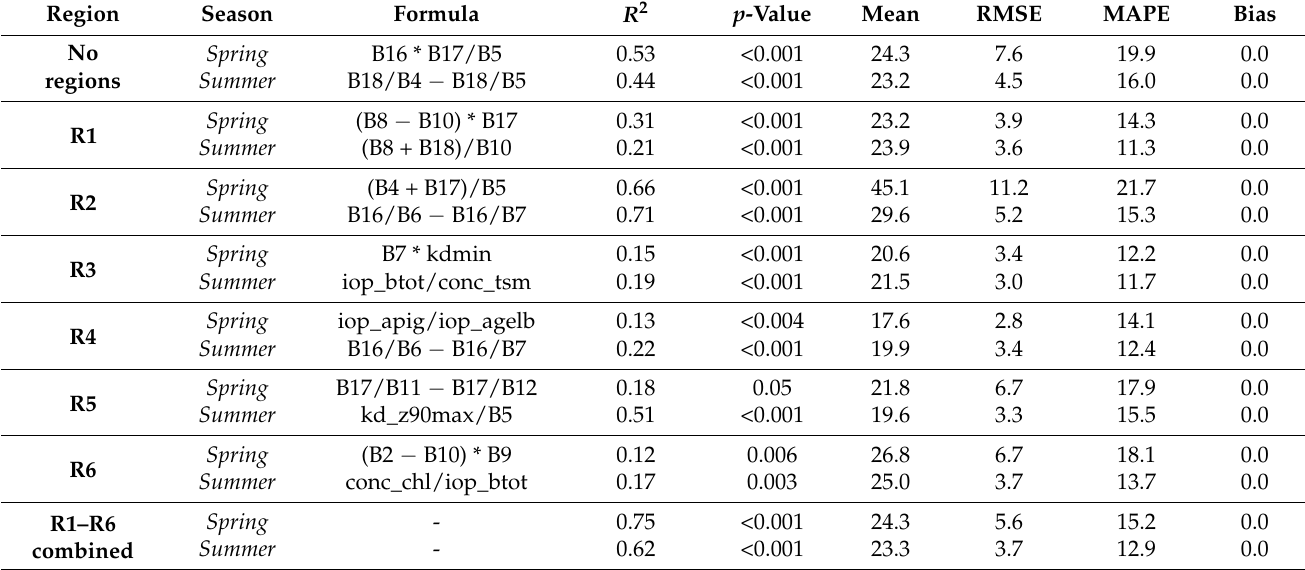
Table 7. The best formulas (B in the formulas indicates the C2RCC reflectance band, and the number indicates the band number), the determination coefficient ( R 2 ), p -value, mean and the root mean square error (RMSE) (both in µ molN L − 1 ), the mean absolute percentage error (MAPE), and bias ( µ molN L − 1 ) for each region in spring (April to June) and summer (July to September) for the derived total nitrogen (TN).